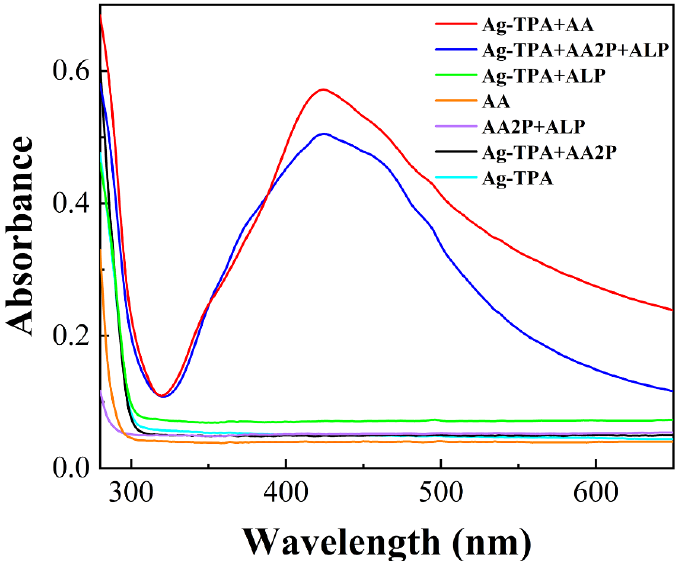
Figure 5. UV – Vis absorption spectra of Ag-TPA + AA (red line), Ag-TPA + AA2P + ALP (blue line), Ag-TPA + ALP (green line), AA (orange line), AA2P + ALP (purple line), Ag-TPA + AA2P (black line), and Ag-TPA (cyan line). Note: c (ALP): 10 mU/mL; c (AA2P): 0.25 mM; c (AA): 0.20 mM; Ag-TPA CPN solution: 50 μ L.